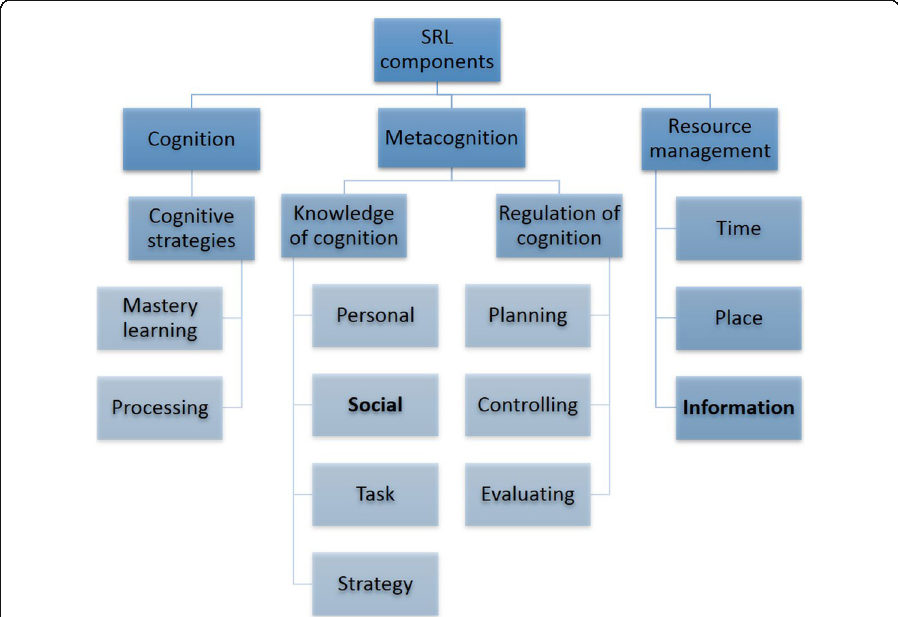
Fig. 2 SRL components identified in students ’ statements about their learning